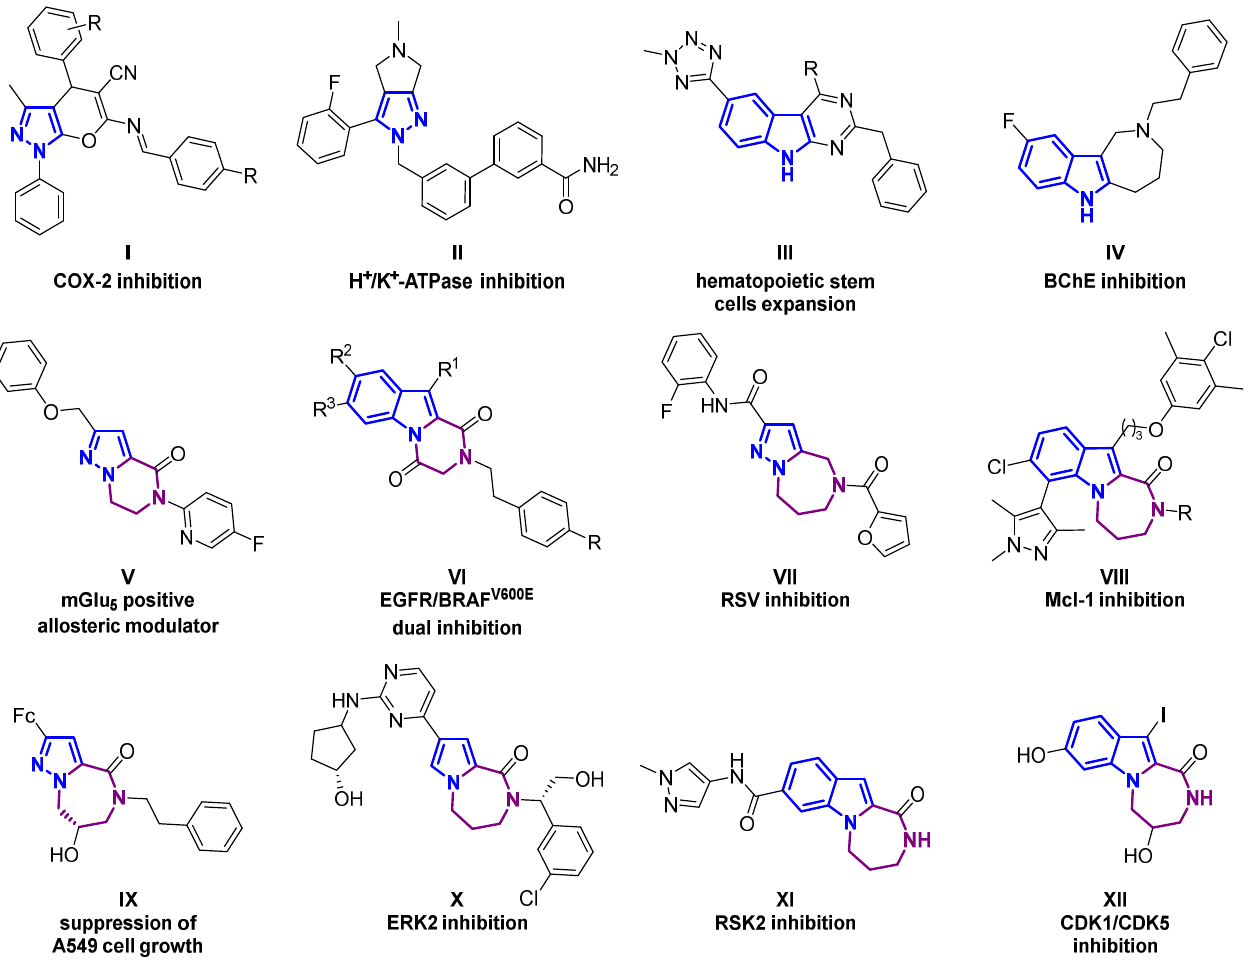
Figure 1. Biologically relevant fused heterocyclic derivatives.